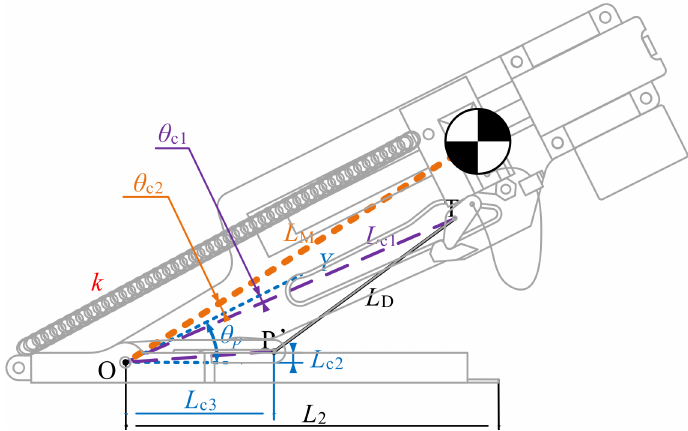
Figure 8. Five typical stages of the mechanism with some components marked.